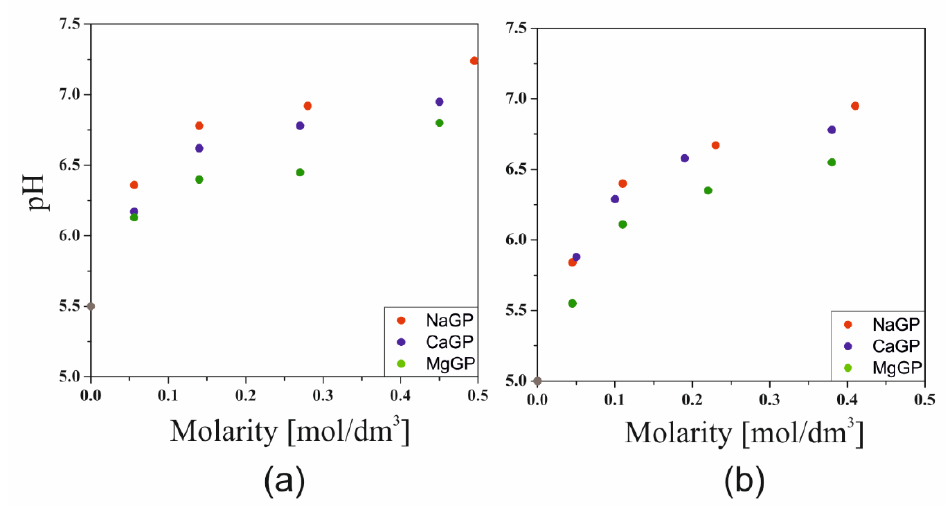
Figure 1. Changes in the pH value of solutions of crab chitosan chlorides ( a ) and acetates ( b ) as a function of glycerophosphate concentration. The data for the system containing the addition of calcium glycerophosphate using acetic acid come from the authors’ own research published earlier [32].